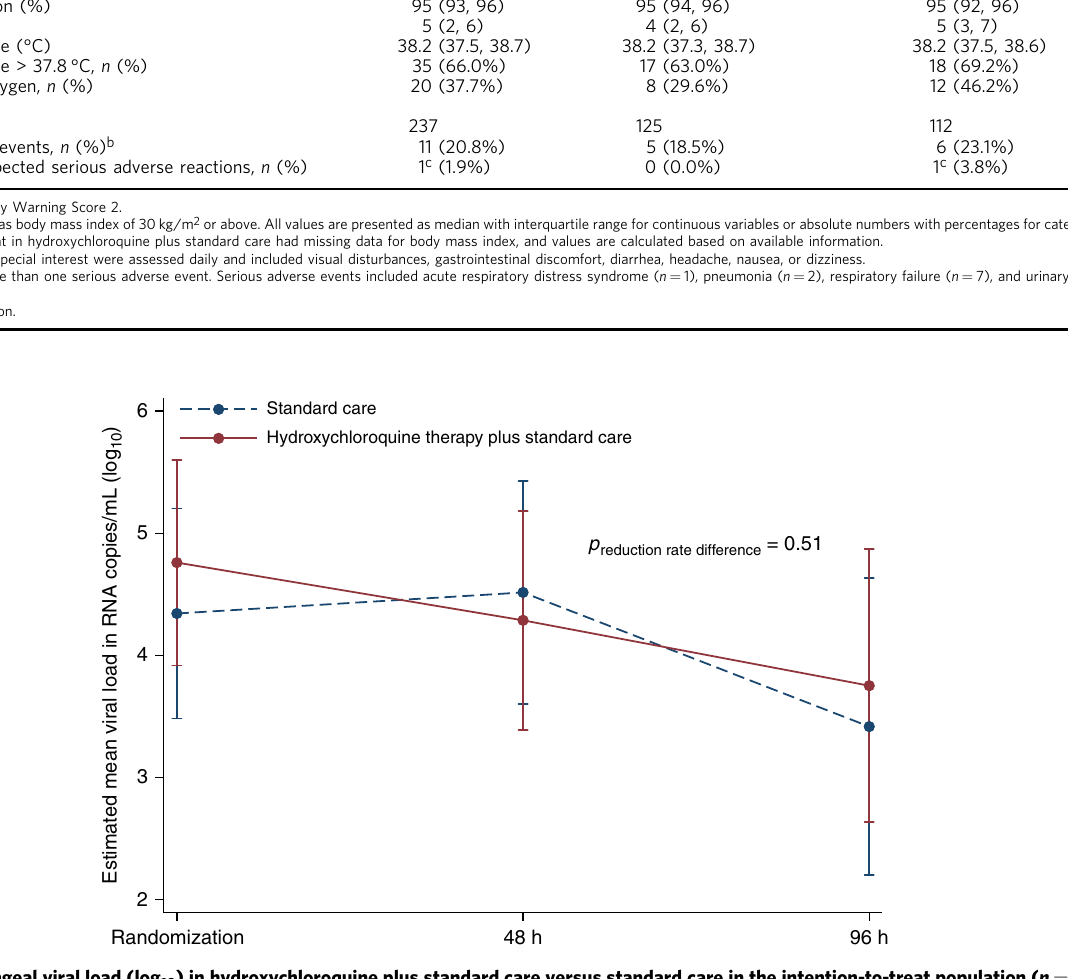
Fig. 2 Oropharyngeal viral load (log 10 ) in hydroxychloroquine plus standard care versus standard care in the intention-to-treat population ( n = 51; full analysis set). One patient in the hydroxychloroquine plus standard care had missing baseline data for viral concentrations and one patient in standard care withdrew consent before viral load assessment at 48 h. Data are accordingly shown for 26 patients assigned to hydroxychloroquine plus standard care and 25 patients assigned to standard care. Estimated mean difference between groups was 0.27 (95% CI − 0.92 to 1.47) log 10 RNA copies/mL at randomization, 0.06 (95% CI − 1.15 to 1.26) log 10 RNA copies/mL at 48 h, and − 0.16 (95% CI − 1.67 to 1.36) log 10 RNA copies/mL at 96 h. Plot displays estimated marginal means (dots) and 95% con fi dence intervals (error